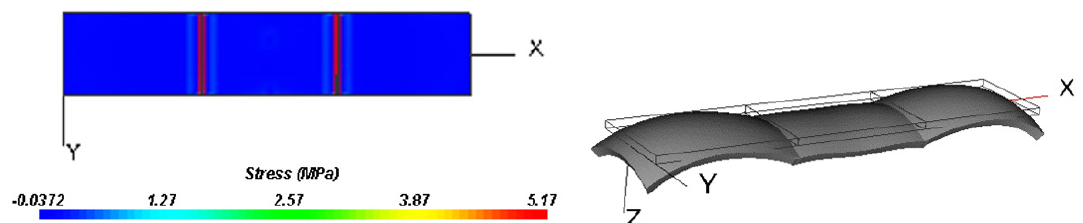
Figure 12. Example of the principal stresses colormap and the deformed shape of the